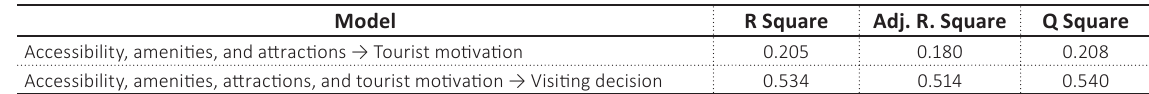
Table 2. R and Q Squares